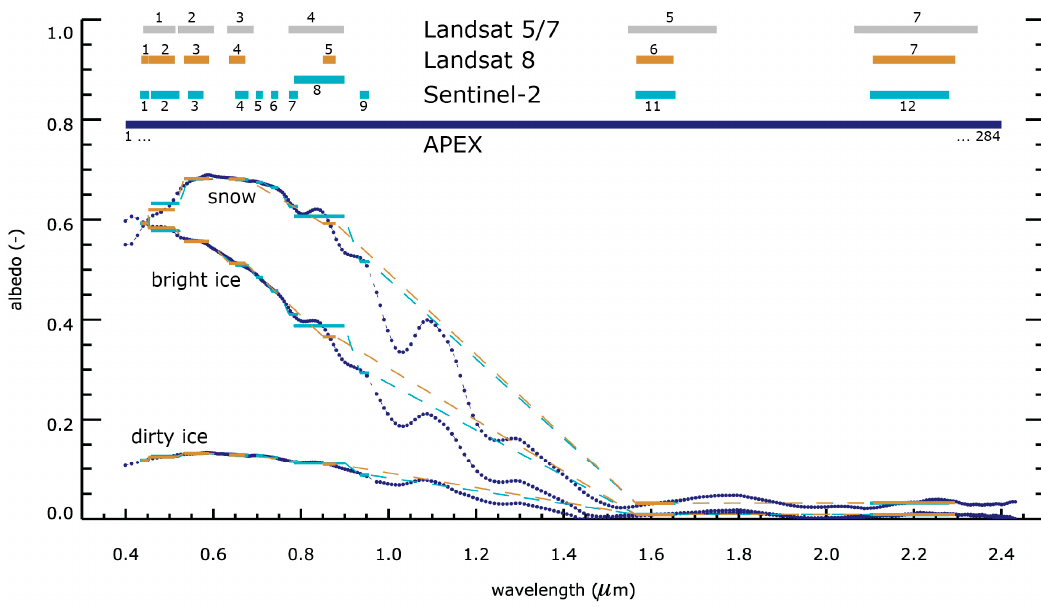
Figure 3. Spectral band positions of Landsat 5/7, Landsat 8, Sentinel-2 and APEX. Three typical surface spectra of snow, bright ice, and dirty ice are plotted. APEX data was used to convolve to Sentinel-2 and Landsat data. The dashed lines represent linear interpolation between individual bands of the multispectral sensors.